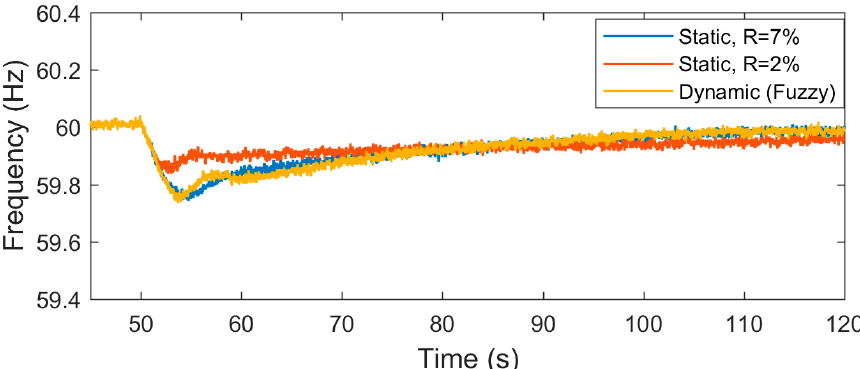
Energies 2019 , 12 , x FOR PEER REVIEW Figure 12. Grid frequency (small ROCOF). Figure 12. Grid frequency (small ROCOF).